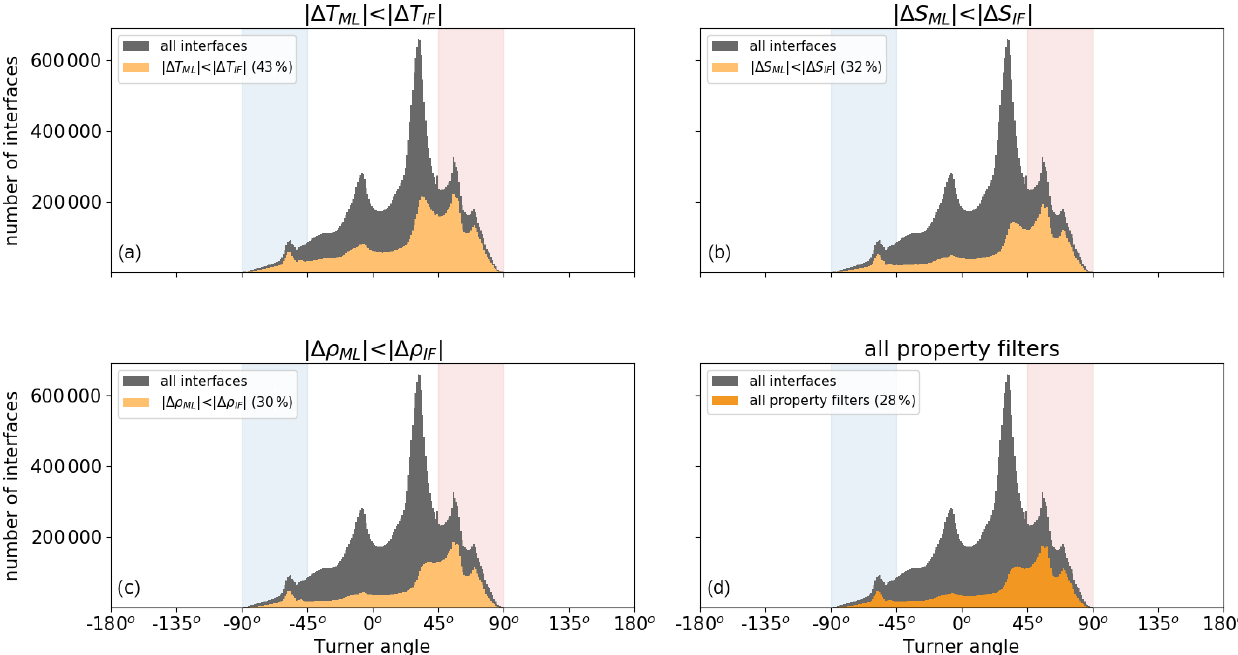
Figure 4. Histogram of the number of detected interfaces as a function of the Turner angle (Tu) by applying a criterion for (a) conservative temperature, (b) absolute salinity, (c) potential density, and (d) all three properties given in Eq. (4) (orange shading). Each panel shows the data remaining compared to the raw interface data (grey). Vertical shaded bands correspond to Turner angles in the diffusive-convective (blue) and salt-finger (red)